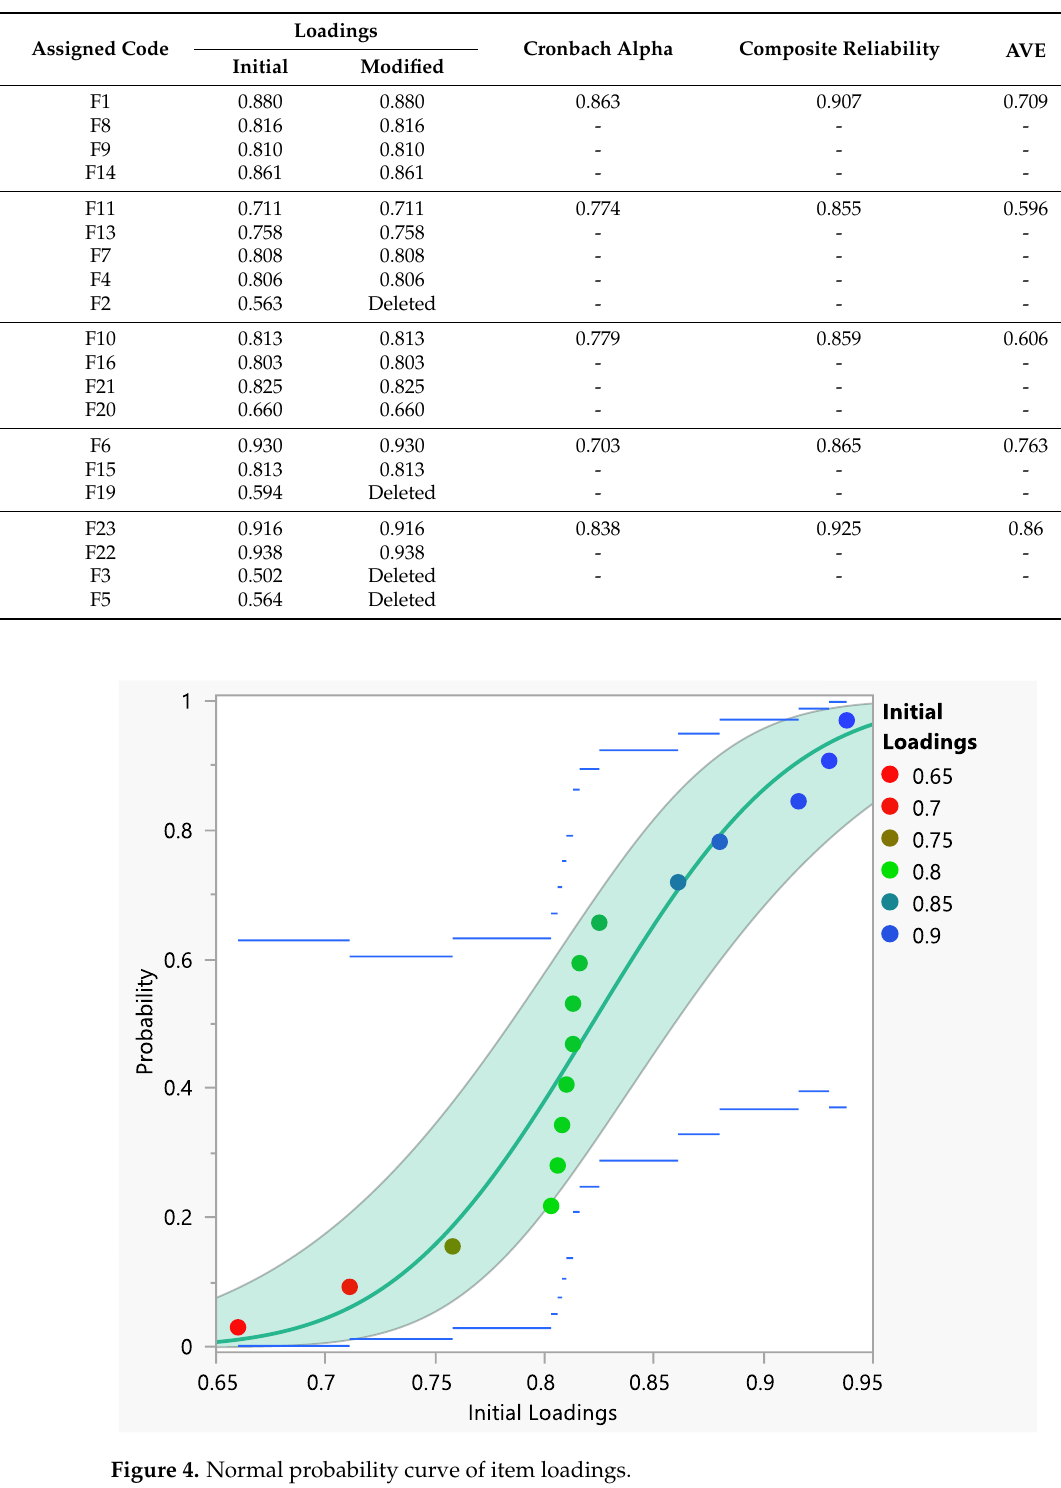
Table 5. Loadings of Variables along with CA, CR and AVE output.